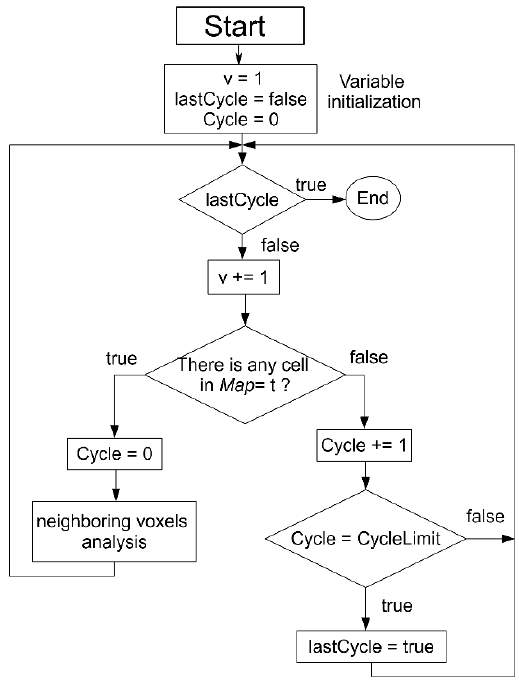
Figure 13. Navigation map generation workflow.